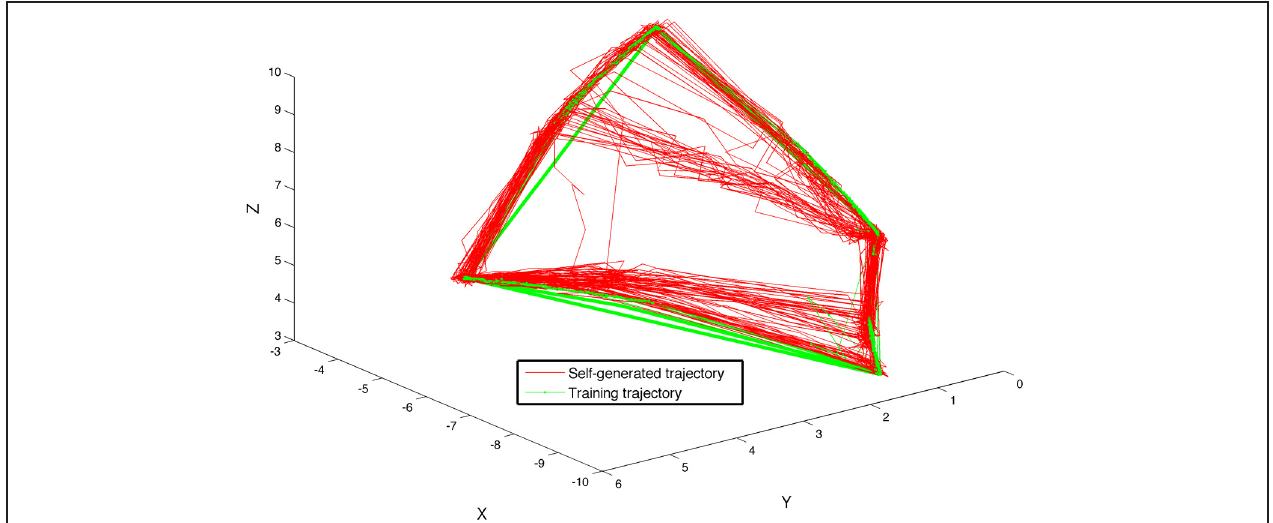
movements after training (red line) for all 5 subjects. Lines are drawn between temporally adjacent data points recorded at 50ms intervals. One of the five subjects showed some error and consistently “cut” the upper corner, generating a different shape than the other four subjects. The self-generated arm trajectories approximate the training